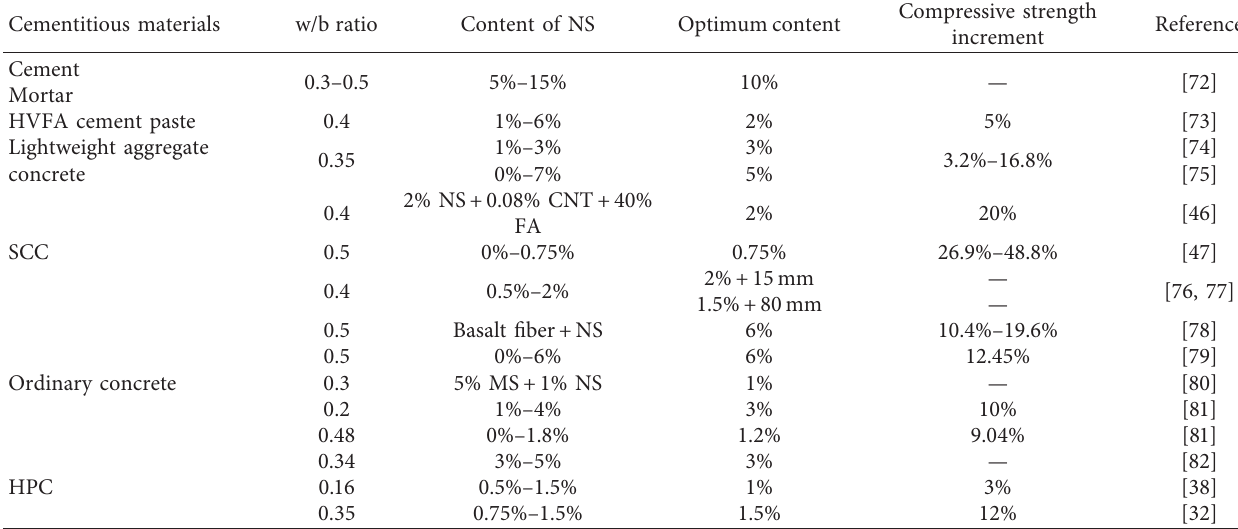
Figure 10: Percentage of flow [71]. Table 2: Compressive strengths of cementitious materials with NS at 28